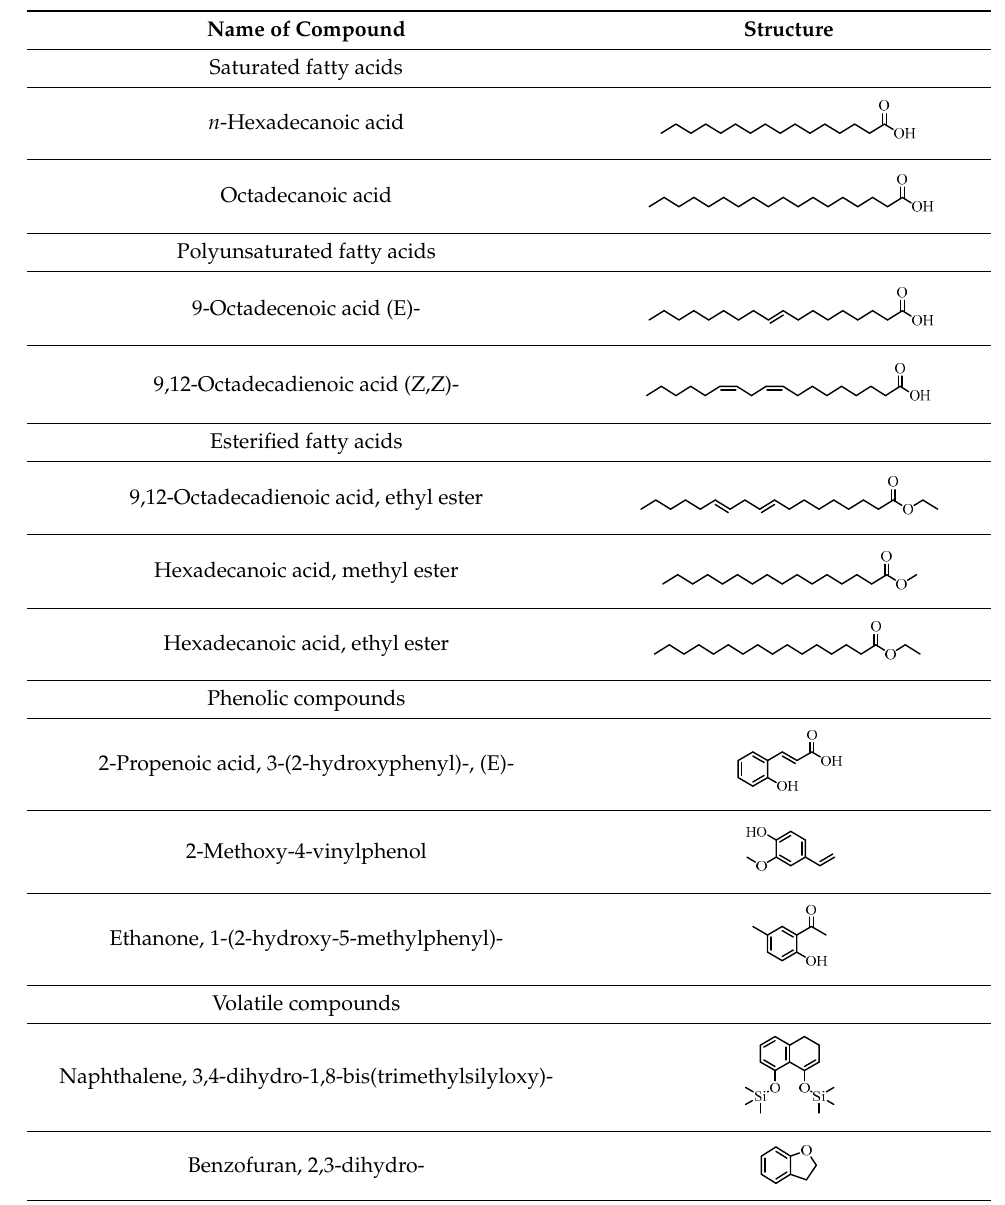
Table 2. Compounds present in extracts EtOH 0%, 50%, 80%, and 100%.